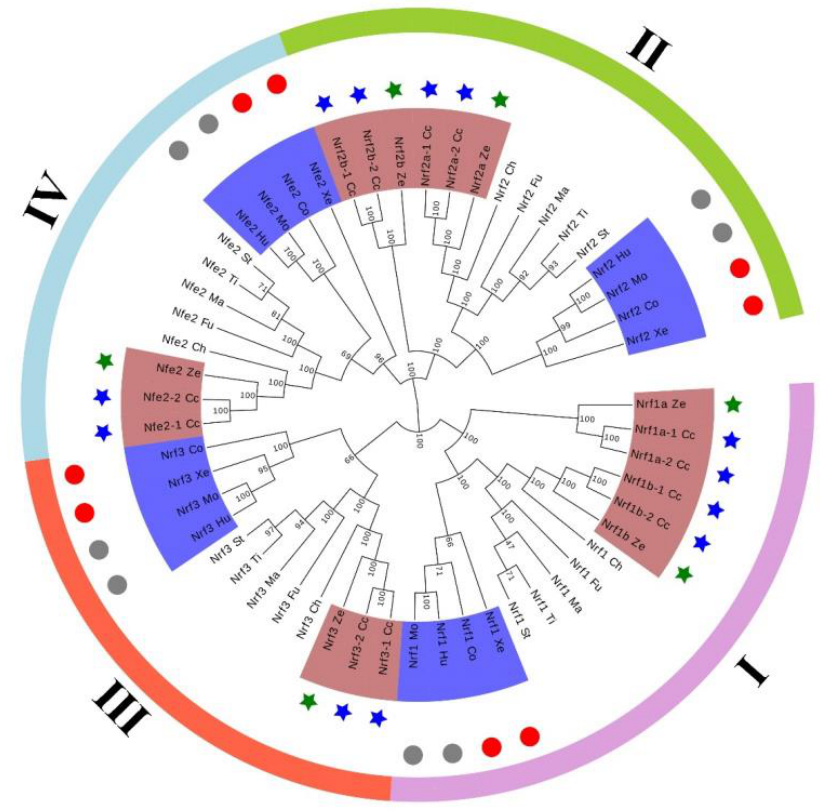
Figure 3. Neighbor-joining-based phylogenetic tree of 54 Nrf protein sequences. Cc represents common carp, Hu represents human, Mo represents mouse, Xe represents clawed frog, Co represents coelacanth, Ze represents zebrafish, Ti represents tilapia, Ma represents medaka, Ch represents channel catfish, St represents stickleback, and Fu represents fugu.